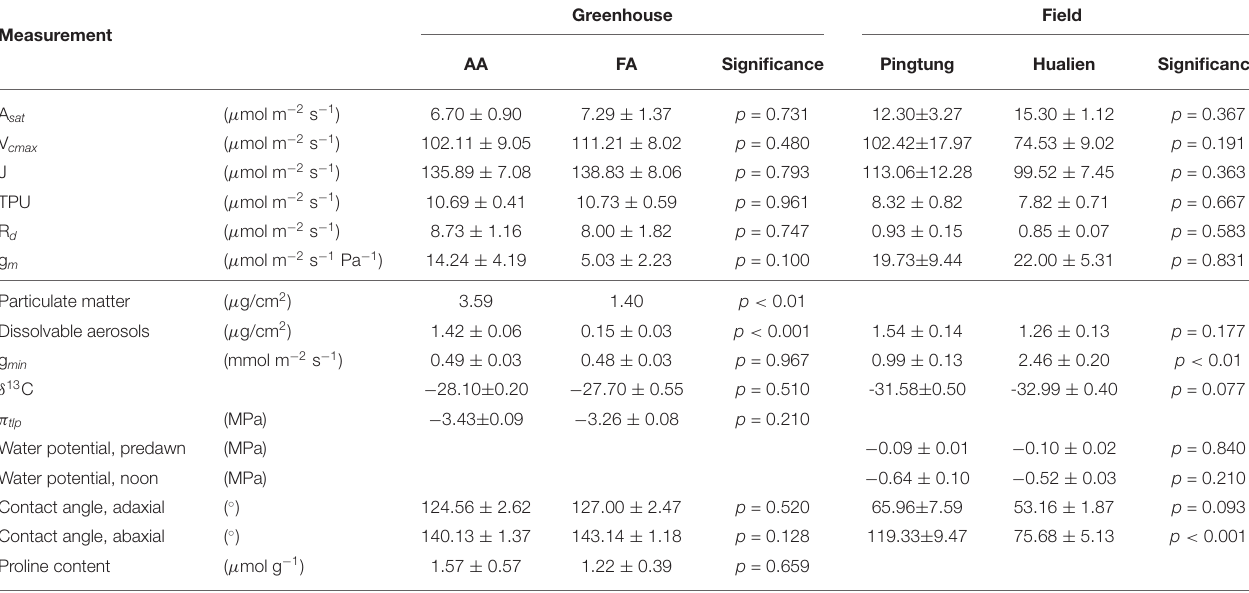
TABLE 2 | Measurements of Cinnamomum camphora leaves from different growing